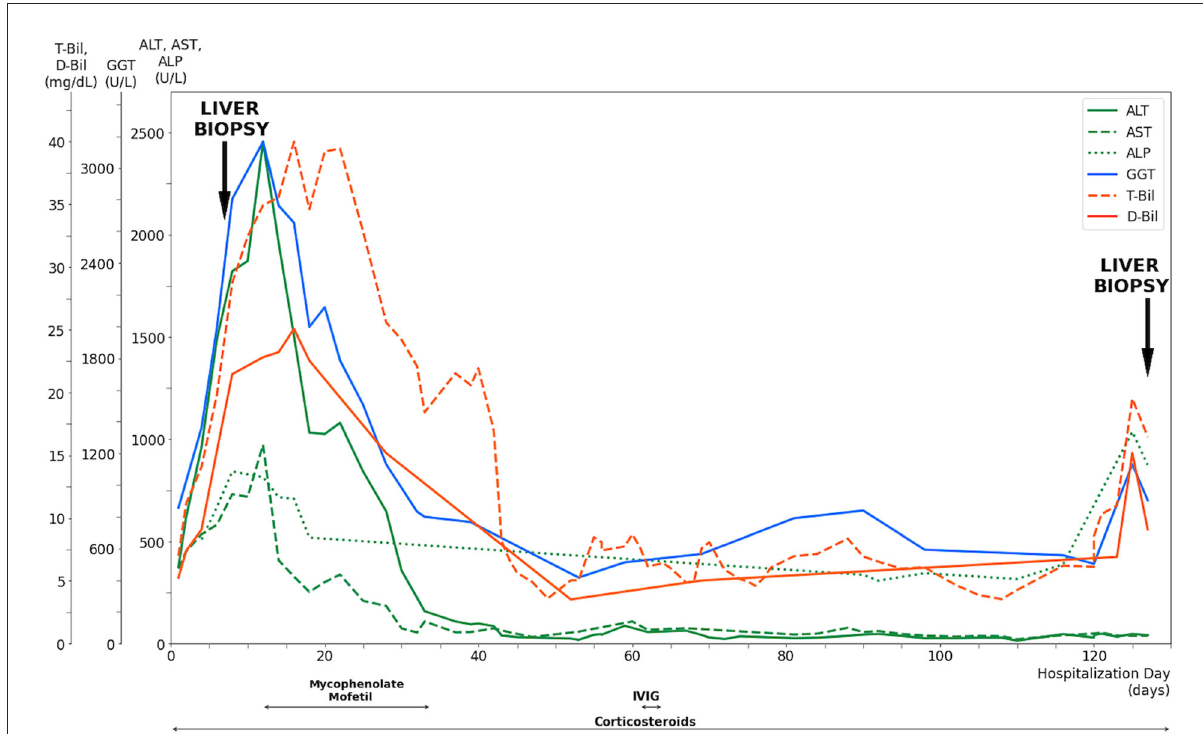
FIGURE2 Evolution of serum liver tests and medications of a 42-year-old male after exposure to NSAIDs. Corticosteroids were given since the diagnosis of Stevens-Johnson Syndrome with titration according to the clinical presentation. The progressive elevation of liver enzymes and jaundice had led to a liver biopsy performed on day 6, along with the confirmed diagnosis of vanishing bile duct syndrome. Mycophenolate mofetil was prescribed after the diagnosis while the patient prepared for liver transplantation, which was not performed due to deterioration of clinical conditions. Intravenous immunoglobulin was administered for 3 days after the bone marrow biopsy revealed hemophagocytic lymphohistiocytosis. The liver enzymes and bilirubin levels remained relatively stable until day 125, when significant elevation was observed. Repeated liver biopsy was performed on day 127, which showed vanishing bile duct syndrome in resolution. T-Bil, total bilirubin level; D-Bil, direct bilirubin level; GGT, gamma glutamyl transferase; ALT, alanine aminotransferase; AST, aspartate aminotransferase; ALP, alkaline phosphatase; IVIG, intravenous immunoglobulin.